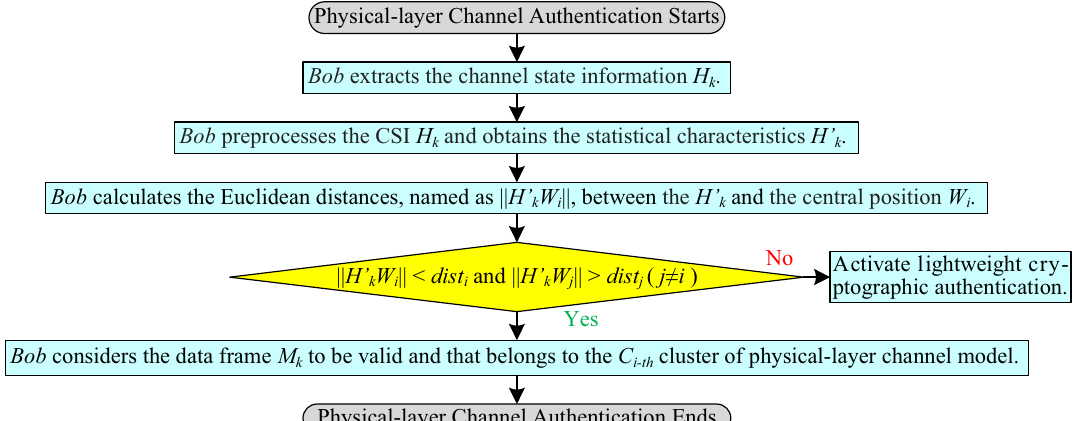
Figure 6. Process flowchart of physical-layer channel